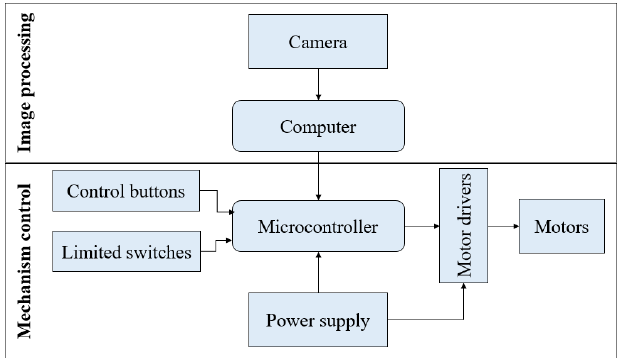
Figure 3. Experimental